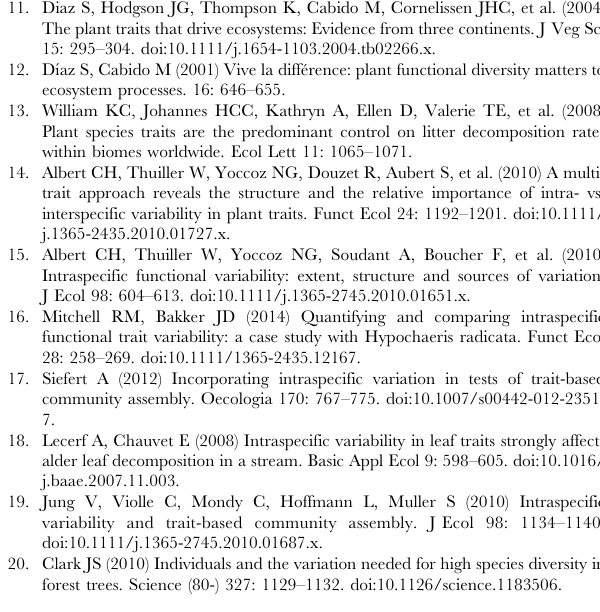
Figure S1 Diagram illustrating selection of populations and maternal lines. Figure S2 Correlation Matrix of Traits. Table S1 Table of Abiotic Conditions at Sample Loca- tions. Table S2 Results of General Linear Mixed